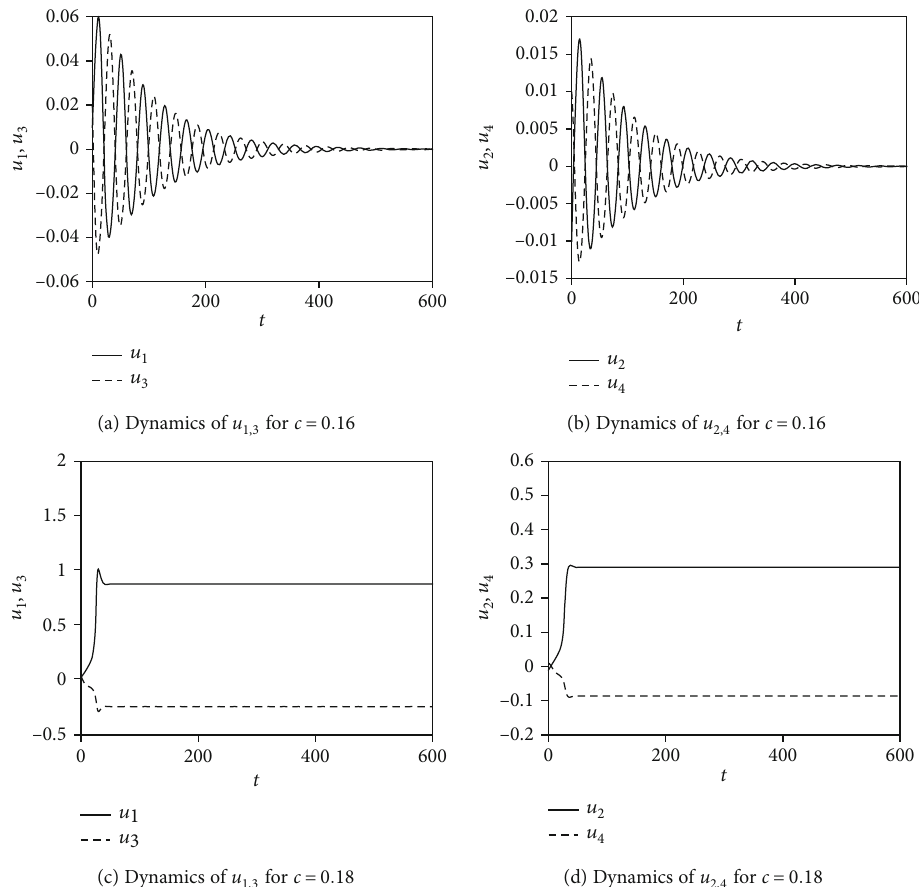
with c = 0 : 16 . (b) The dynamics of u 1,3